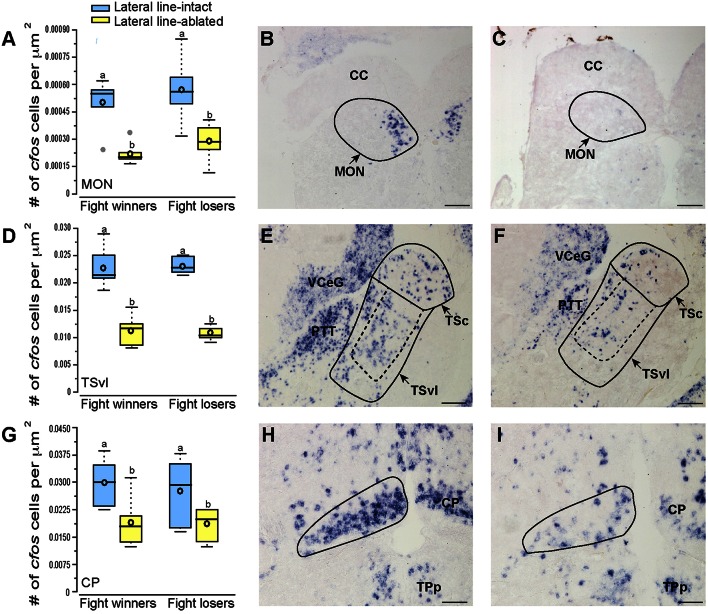
Lateral line-ablated animals have decreased cfos staining in lateral line processing regions of the brain. Quantification of cfos staining in the MON (A), TSvl (D), and CP (G) in lateral line-intact (blue) and -ablated (yellow) fight winners and losers (N = 6 for all groups). Photomicrographs of representative cfos staining (dark blue label) in transverse sections through the MON of a lateral line-intact (B) and -ablated (C) animal, the TSvl of an intact (E) and ablated (F) animal, and the CP of an intact (H) and ablated (I) animal. Solid circles depict nuclei borders and dashed outlines represent the subarea quantified for each nucleus. If no dashed outline is present, the entire nucleus was quantified. Different letters indicate statistical significance at P < 0.05 using post-hoc LSD tests. Scale bars in (B,C,E,F) represent 100 μm. Scale bars in (H,I) represent 25 μm. See Figure 1 legend for box plot descriptions. See list for abbreviations.